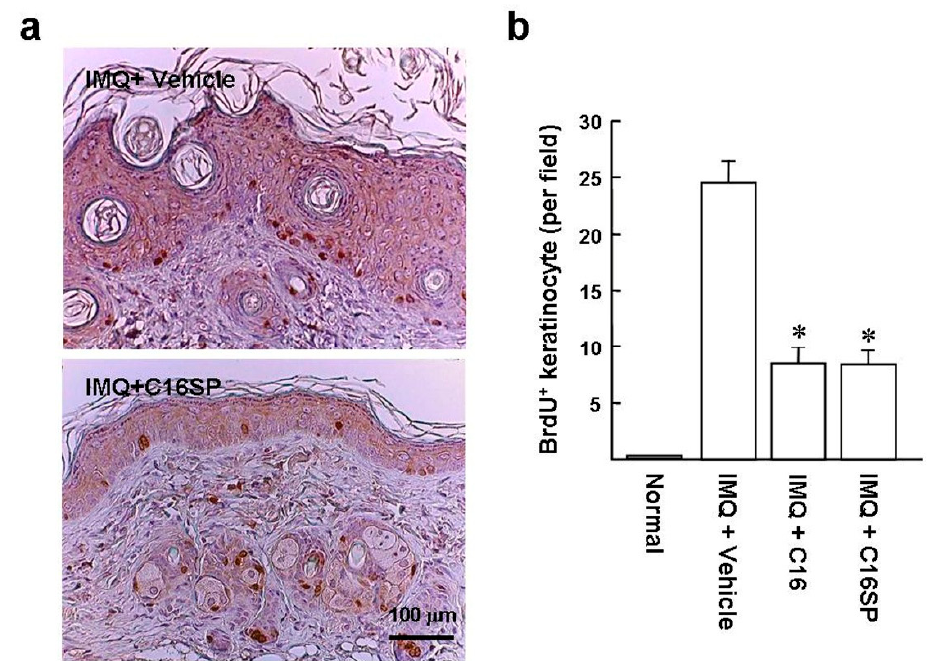
Figure 5. C16 and C16SP suppress IMQ-induced keratinocyte proliferation. Murine dorsal skins were treated with IMQ for five consecutive days and then intraperitoneally injected with BrdU for another 24 h, before being euthanized. ( a ) BrdU immunostaining (brown) and counterstaining with hematoxylin. Representative images are from six sections per mouse skin, with six mice per group. ( b ) Numbers of BrdU-positive cells in the basal layer of the epidermis. The digital image analysis of BrdU + keratinocytes was performed blinded on an average of six randomly selected 200 × magnification fields from each section, using a Nikon Eclipse 80i microscope equipped with a Leica DC 500 camera. * p < 0.0001 versus IMQ / vehicle-treated group.